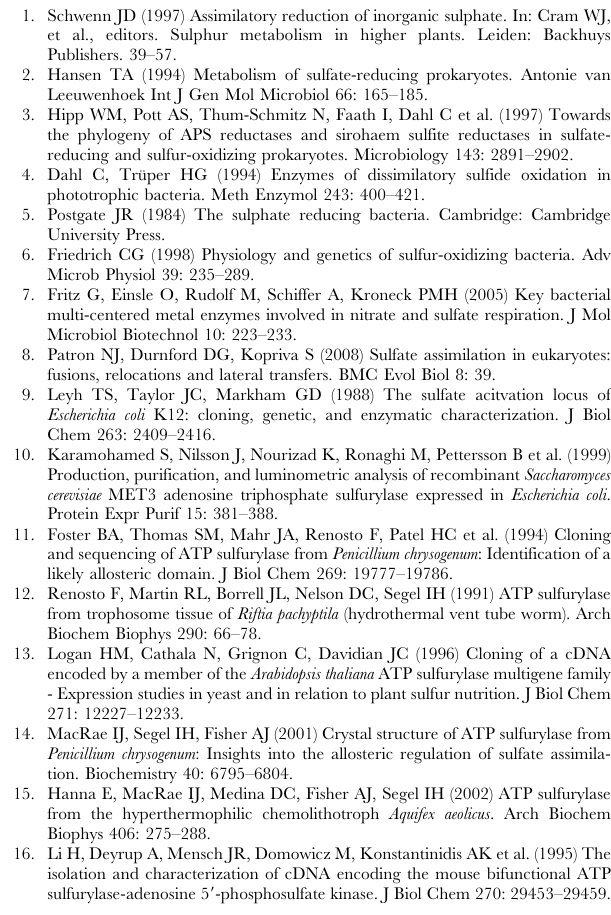
Figure S1 Simulation of the proposed ATPS-APS-PP i adduct (A) and ATPS-ATP product (B). The highly conserved 199 QXRNXXHXXH 208 motif is involved in the coordination of the sulfate and phosphate moiety. Figure S2 Molecular surface representation with em- phasis on the deep cleft within the catalytic domain. The